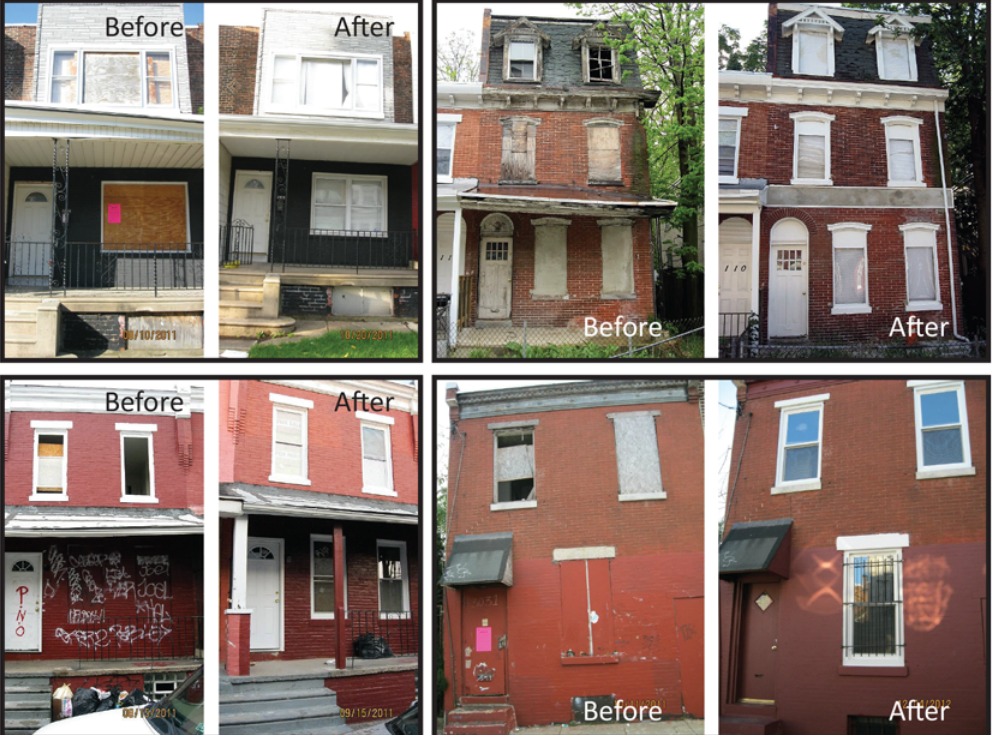
Fig 1. Before and After Photos of Renovated Vacant Properties. This figure shows four properties that received doors-and-windows remediation. Pink posters on doors of properties shown in the upper left- and lower right-hand quadrants notify the owner of a date by which the structure must be in compliance or face